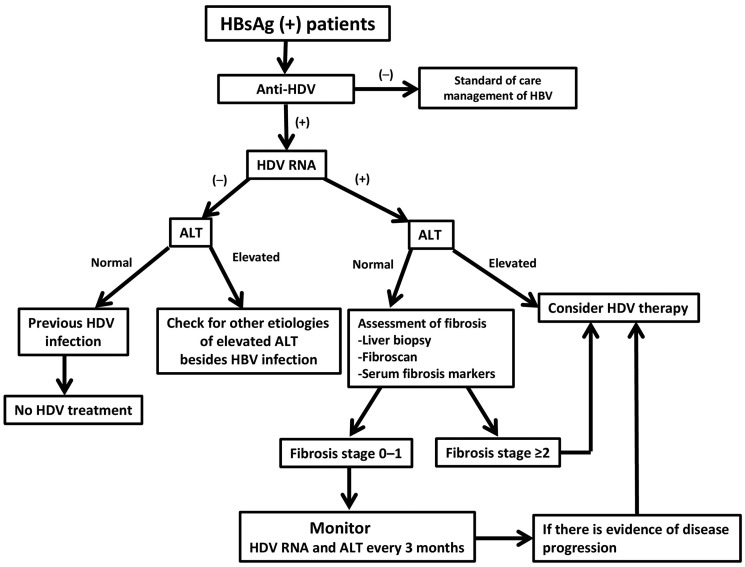
Algorithm for the evaluation of chronic hepatitis D